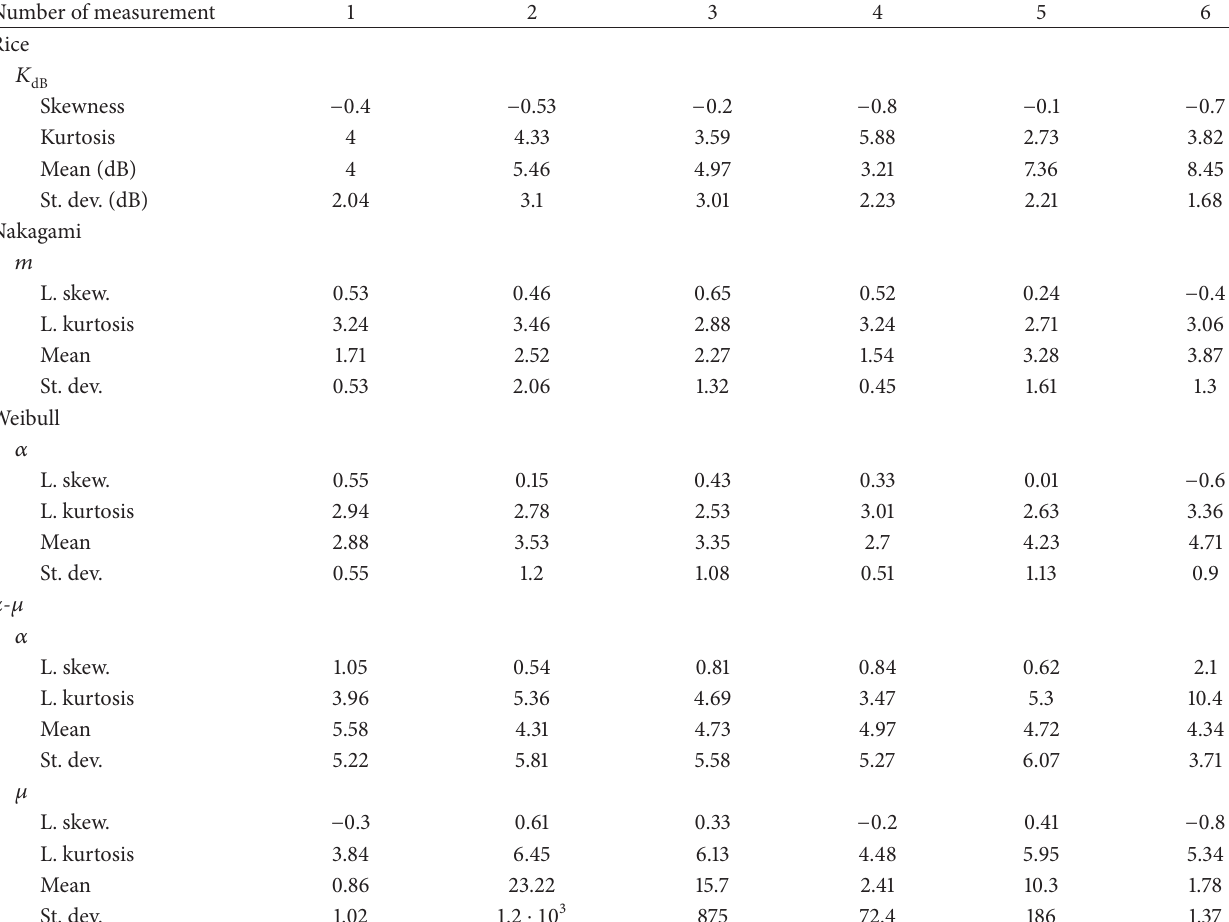
Table 4: Sample mean, standard deviation, log skewness, and log kurtosis of the main parameters of the estimated distributions. Number of measurement